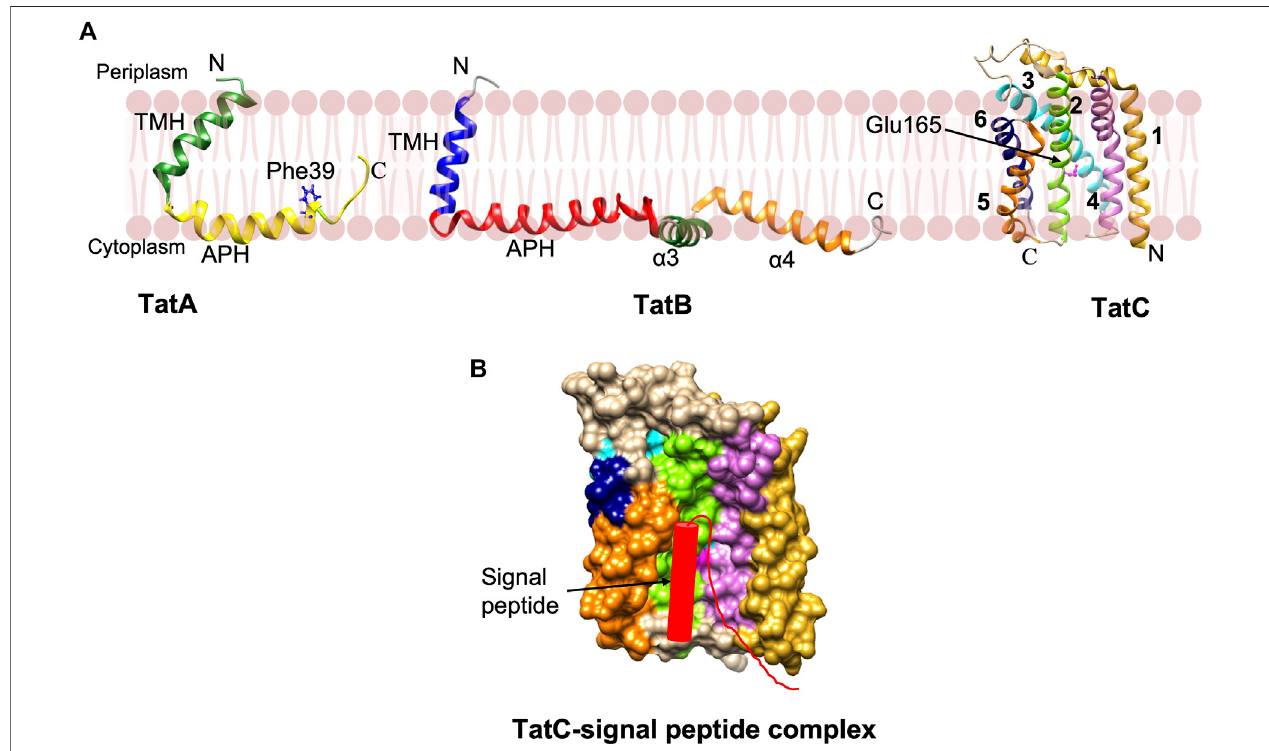
FIGURE 7 | The Tat complex components and a model of TatC-signal peptide complex. (A) The single span TatA (PDB: 2MN7) and TatB (PDB: 2MI2) proteins weredeterminedbyNMR(Rodriguezetal.,2013;Zhangetal.,2014).Thestructure of6membranespanningTatC[adapted fromRollaueret al.(2012) PDB:4B4A]was solved by X-ray crystallography (Rollauer et al., 2012; Ramasamy et al., 2013). (B) The model of TatC binding with the Tat signal peptide in the groove adapted from Ramasamy et al. (2013). Only signal peptide and early mature region of the preprotein are indicated.